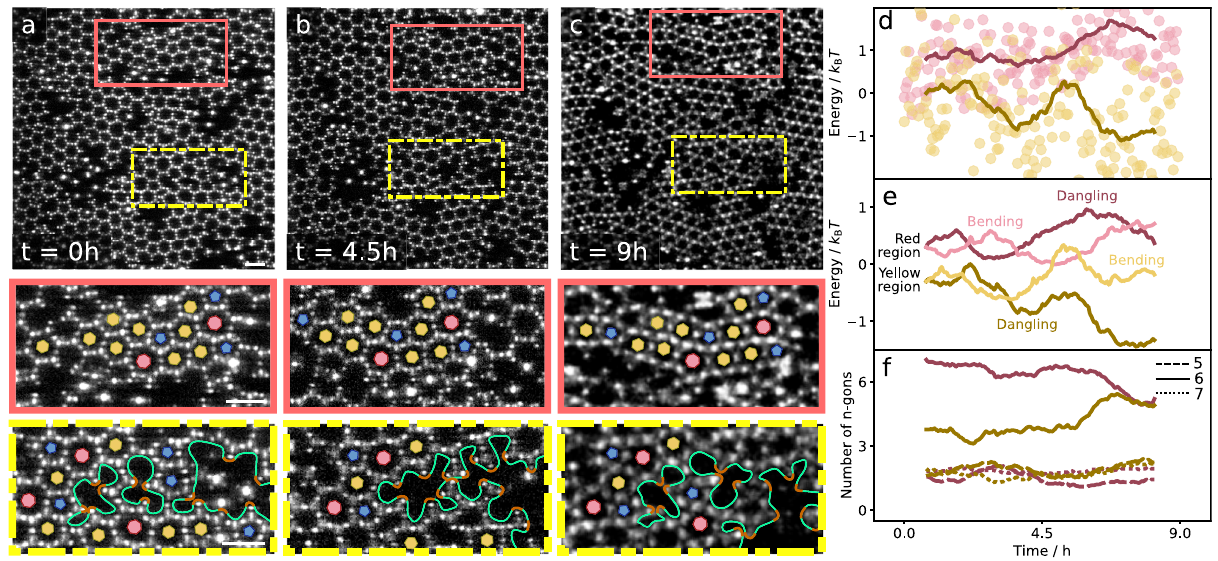
Fig. 4 | Defect evolution in colloidal graphene. a – c Top: Confocal microscope images showing a colloidal graphene polycrystal in its initial con fi guration ( a ) and after 4.5 ( b ) and 9h ( c ) of equilibration at Δ T =0.05°C. Red and yellow rectangles demarcate regions with static and highly dynamic grain boundaries, respectively. Bottom: Enlarged sections corresponding to the demarcated regions on top. In thesesections,6-memberedringsareindicatedwithyellowhexagons,5-membered rings with blue pentagons, and 7-membered rings with red heptagons. The green solid lines bound poly-vacancies, the orange line segments indicate dangling bonds. Vacancies with 3 dangling bonds are typically monovacancies, vacancies with 4 dangling bonds divacancies. Scale bars in ( a ) correspond to 5 μ m. d Total energyperparticlecomputedfromdanglingbondsandbondbendingasafunction